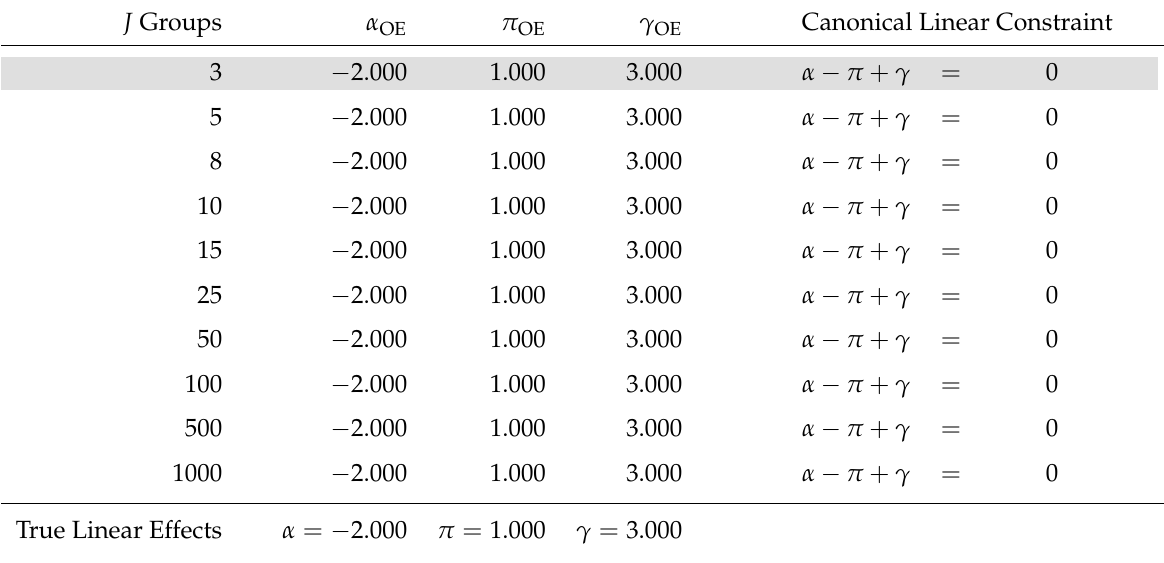
Table 9: Robustness of the OE to number of period (and cohort) groups. J